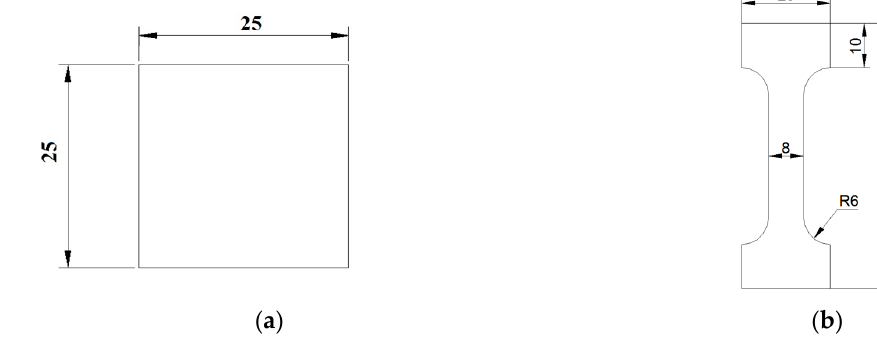
Figure 3. XRD patterns of the steel specimens: ( a ) — before exposure to; ( b ) — after exposure.